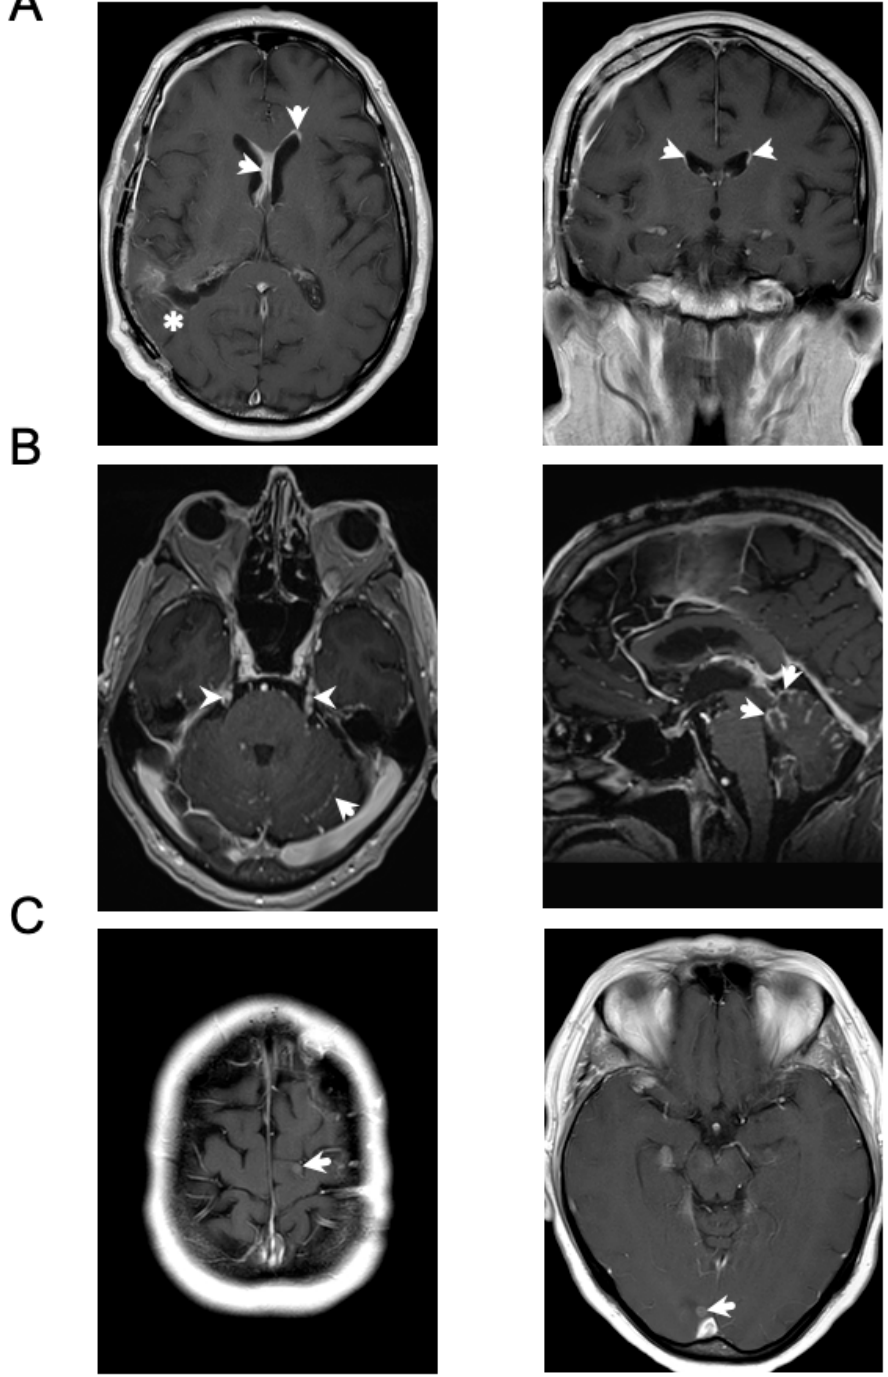
Figure 3. Different appearances of LM by magnetic resonance imaging (MRI). ( A ) Patient with melanoma brain metastases. Axial (left) and coronal (right) T1 post contrast images demonstrate ependymal metastases along the lateral ventricles (arrows). There are also post-surgical changes related to the prior resection of a parietal parenchymal metastasis (asterisk). ( B ) Patient with lung cancer brain metastases. Axial (left) and sagittal (right) T1 post contrast images demonstrate linear, “classical”, leptomeningeal metastases along the trigeminal nerves (arrowheads) and “sugarcoating” the cerebellum (arrows). ( C ) Patient with lung cancer brain metastases. Axial T1 post contrast images demonstrate multiple small, superficially-located lesions, representing nodular leptomeningeal metastases